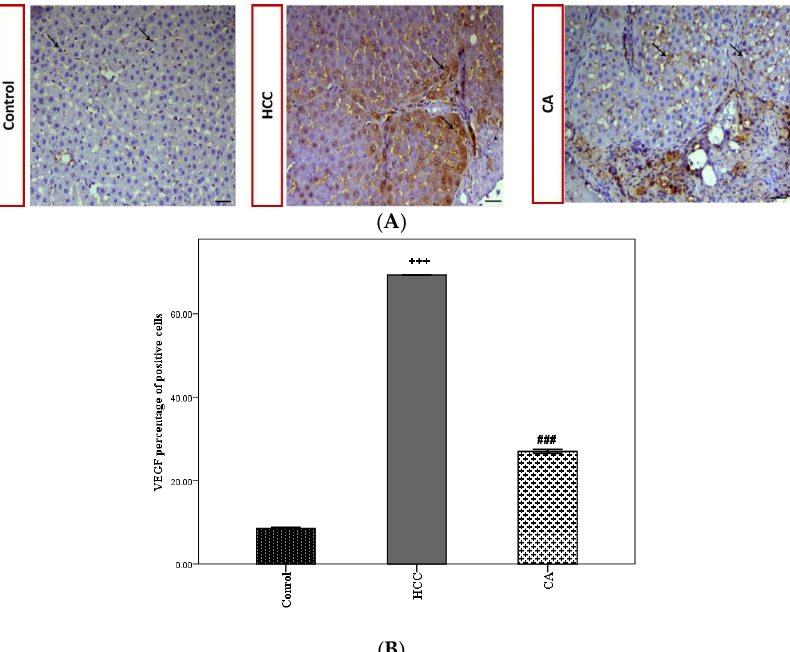
Figure 6. Effect of CA on VEGF expression within the hepatic tissue. ( A ) Immunohistochemical stained liver sections of VEGF, black arrows indicate VEGF antibody positive regions. Scale bar = 50 µm. ( B ) VEGF percentage of positive cells in hepatic tissue. Data were expressed as mean ± S.E.M. Te rats in each group. +++ p < 0.001 vs. control group, ### p < 0.001 vs. HCC group.